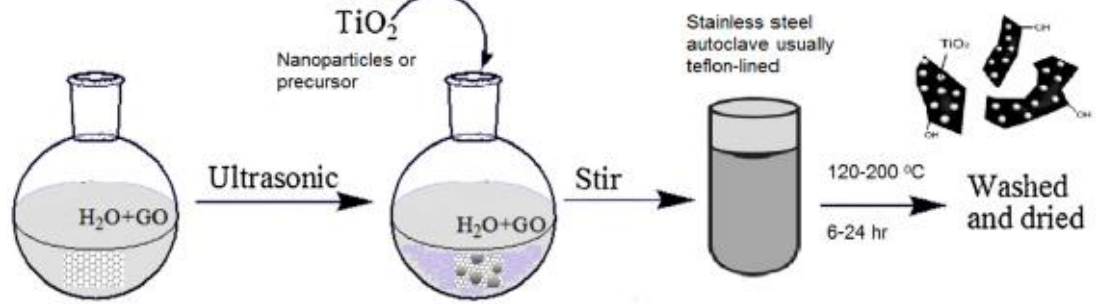
Figure 4. Schematic diagram of hydrothermal synthesis of GO-TiO 2 nanocomposites. Reprinted with permission from [108] Copyright 2012 American Chemical Society.